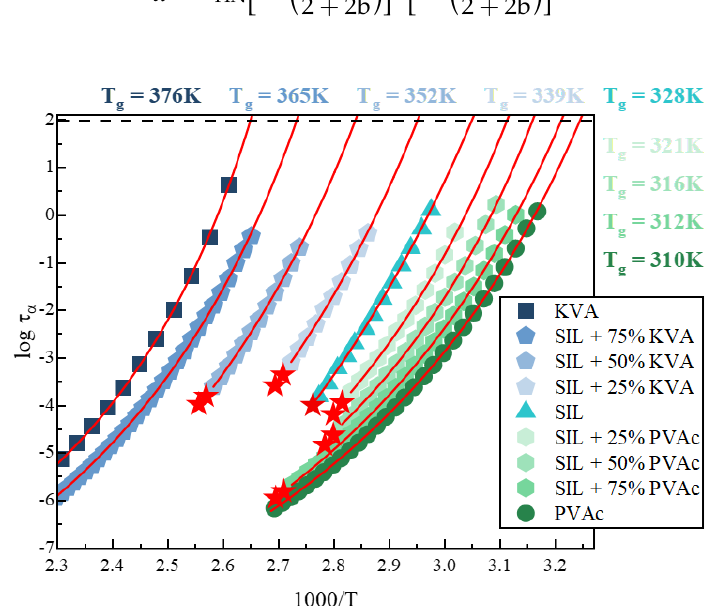
Figure 4. Relaxation map of binary mixtures of (from left): KVA (royal square), SIL + 75 wt.% KVA (cornflower pentagon), SIL + 50 wt.% KVA (baby blue pentagon), SIL + 25 wt.% KVA (celeste blue pentagon), SIL (aqua triangles), SIL + 75 wt.% KVA (cornflower pentagon), SIL + 75 wt.% KVA (cornflower pentagon), SIL + 75 wt.% KVA (cornflower pentagon) and PVAc (olive circles). Red stars indicate the crystallization onset. Temperature dependence of τ α in the supercooled liquid was described by Vogel–Fulcher–Tamman (VFT) equations (red solid lines). Data regarding neat SIL were taken from